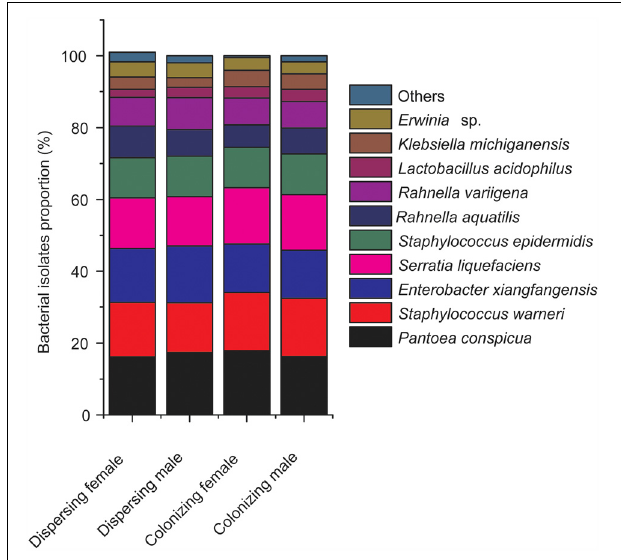
FIGURE 2 | Composition and relative proportion of Dendroctonus valens gut associated facultative bacteria. Species with fewer than 2% were pooled as